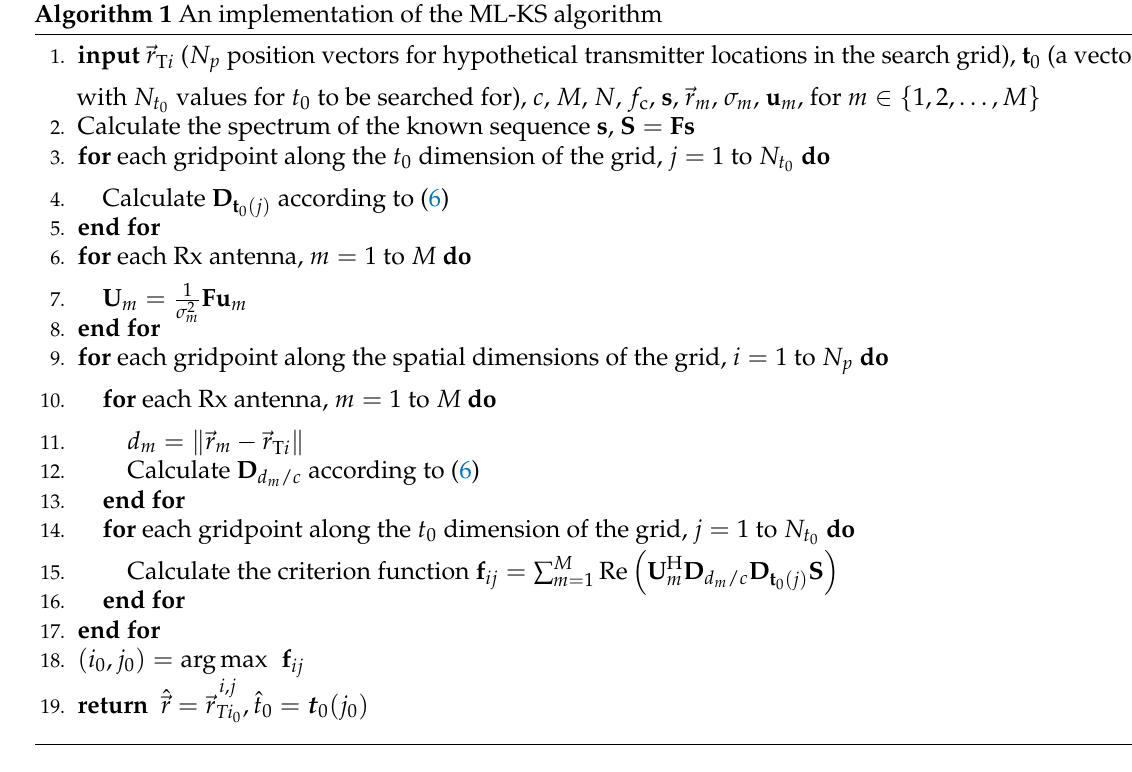
Algorithm 1 An implementation of the ML-KS